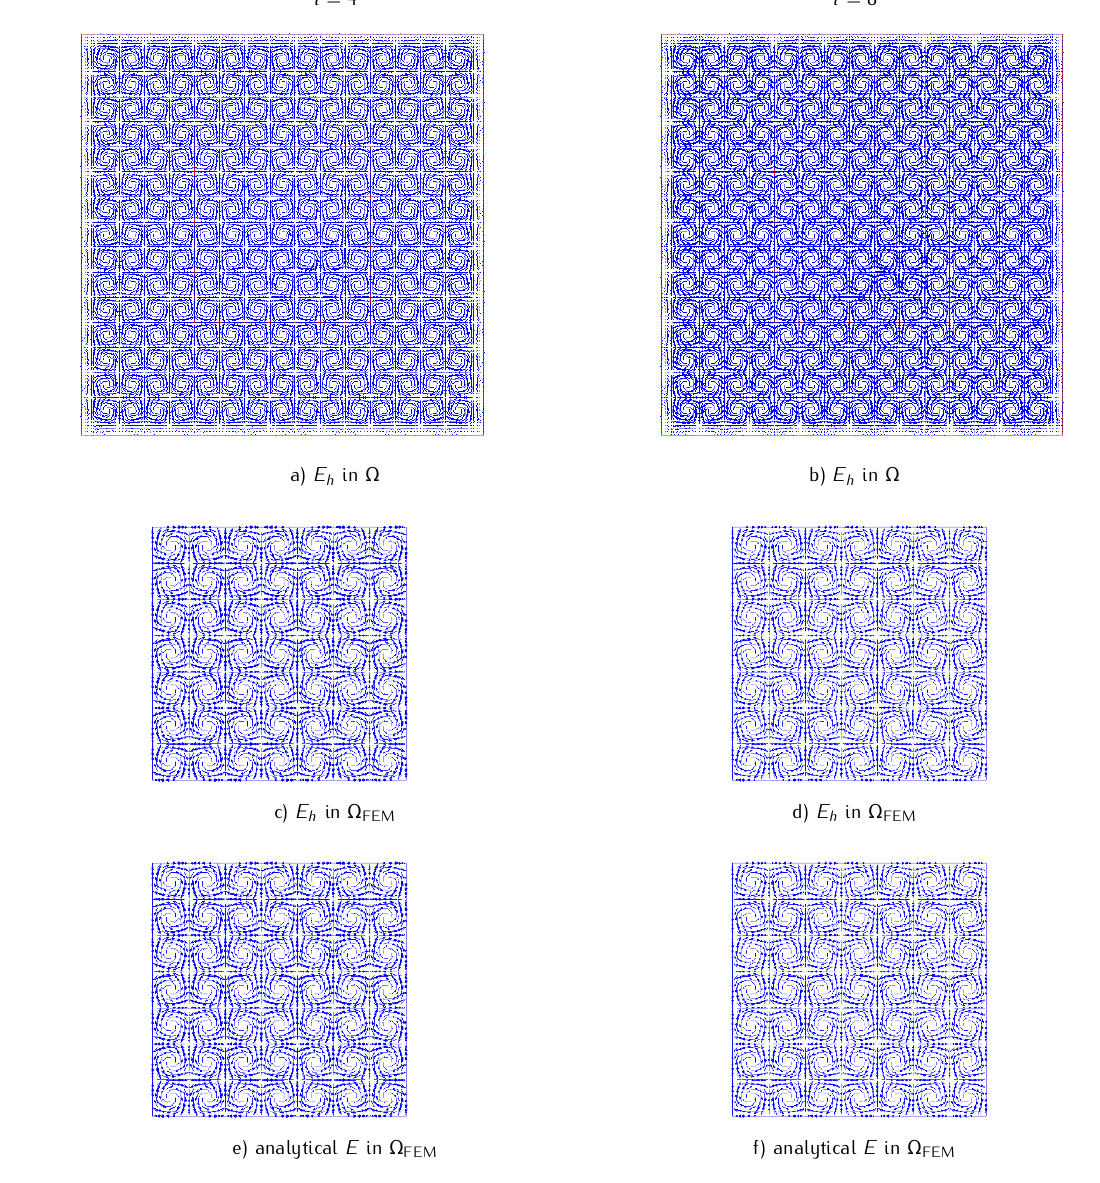
Figure 5. Test 1. Behavior of the computed vector electric field E h = ( E 1 h ,E 2 h ) and the analytical one in the domain decomposition FEM/FDM at time moments t = 4 . 0 and t = 8 , respectively. We show in a) and b) the computed vector electric field E h = ( E decomposition FEM/FDM in Ω . In c) and d) the computed vector electric field E h = ( E vector field E = ( E is presented in Ω ,E 1 2 ) FEM